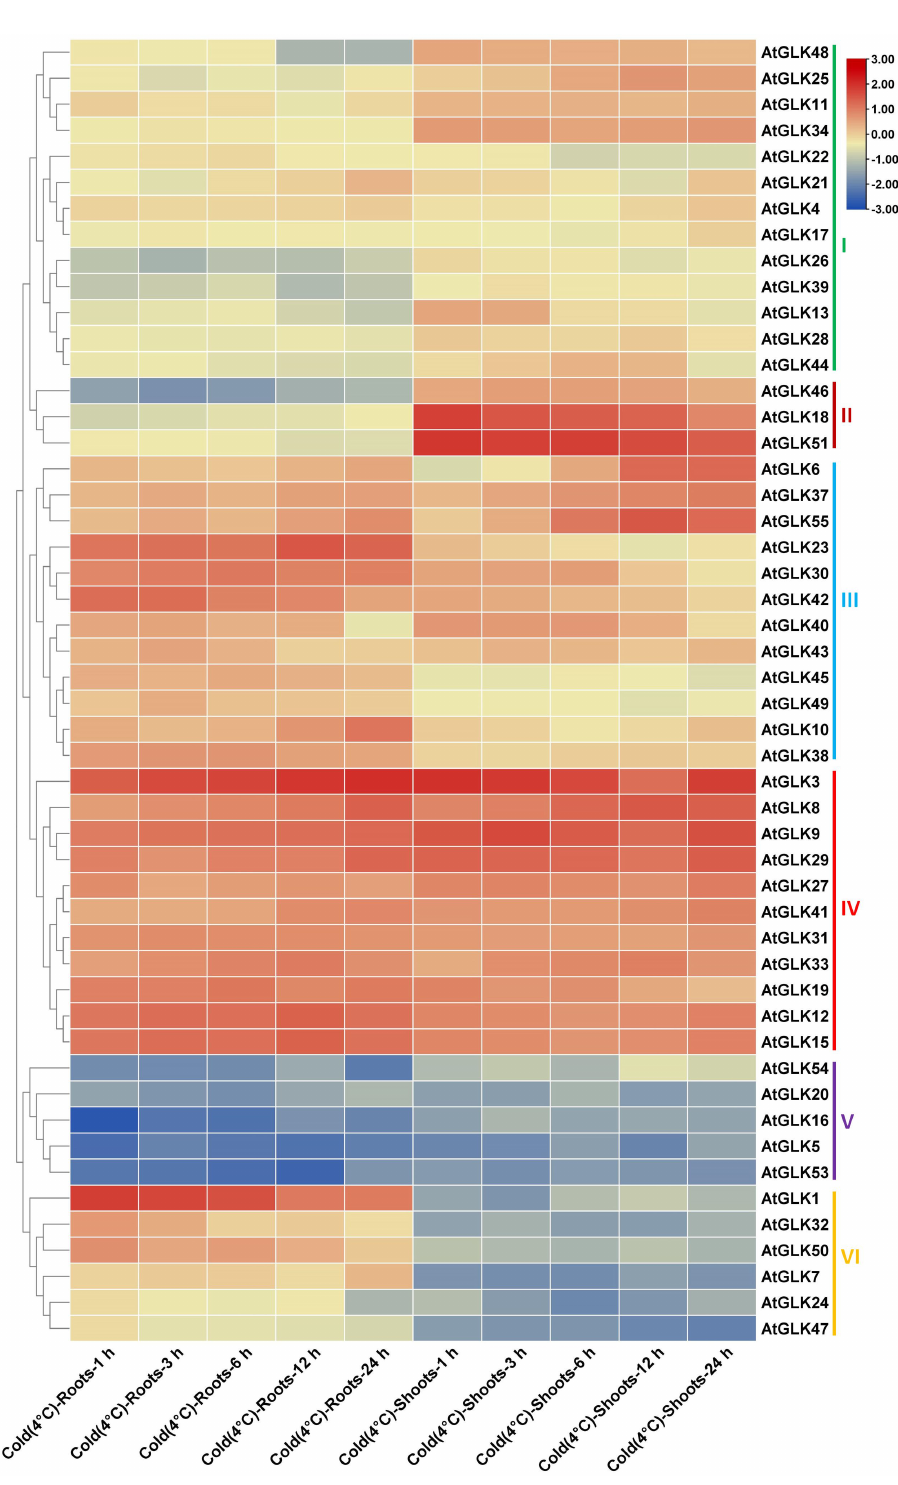
Figure 6. The expression of AtGLK genes in roots and shoots under cold responses. Heatmap generated from microarray experiments. Treatments and replicate numbers were determined by Kilian et al. [36]. Two biological replicates’ intensity values were pooled and normalized following the control treatment (treatment/control) in the heatmap. Control roots and shoots represent non-stressed tissue. The red and the blue intensities show high and low expression levels,